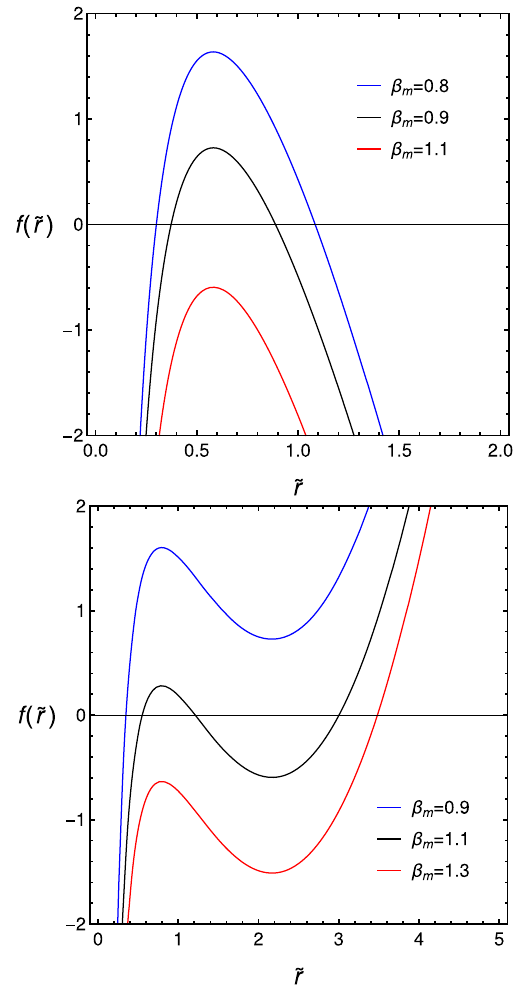
Fig. 2 The left panel shows the horizon structure of the asymptotic de Sitter solution in dRGT massive gravity for the value of β m as β m = 0 . 8 (blue line), β m = 0 . 9 (black line) and β m = 1 . 1 (red line). The right panel shows the horizon structure of the asymptotic AdS solution in dRGT massive gravity for the value of β m as β m = 0 . 9 (blue line), β = 1 . 1 (black line) and α = 1 . 3 (red line). We set parameters as m m M = 1, α g = 1 and c 2 = − 1 for the asymptotic de Sitter solution and c 2 = 1 for the asymptotic AdS solution